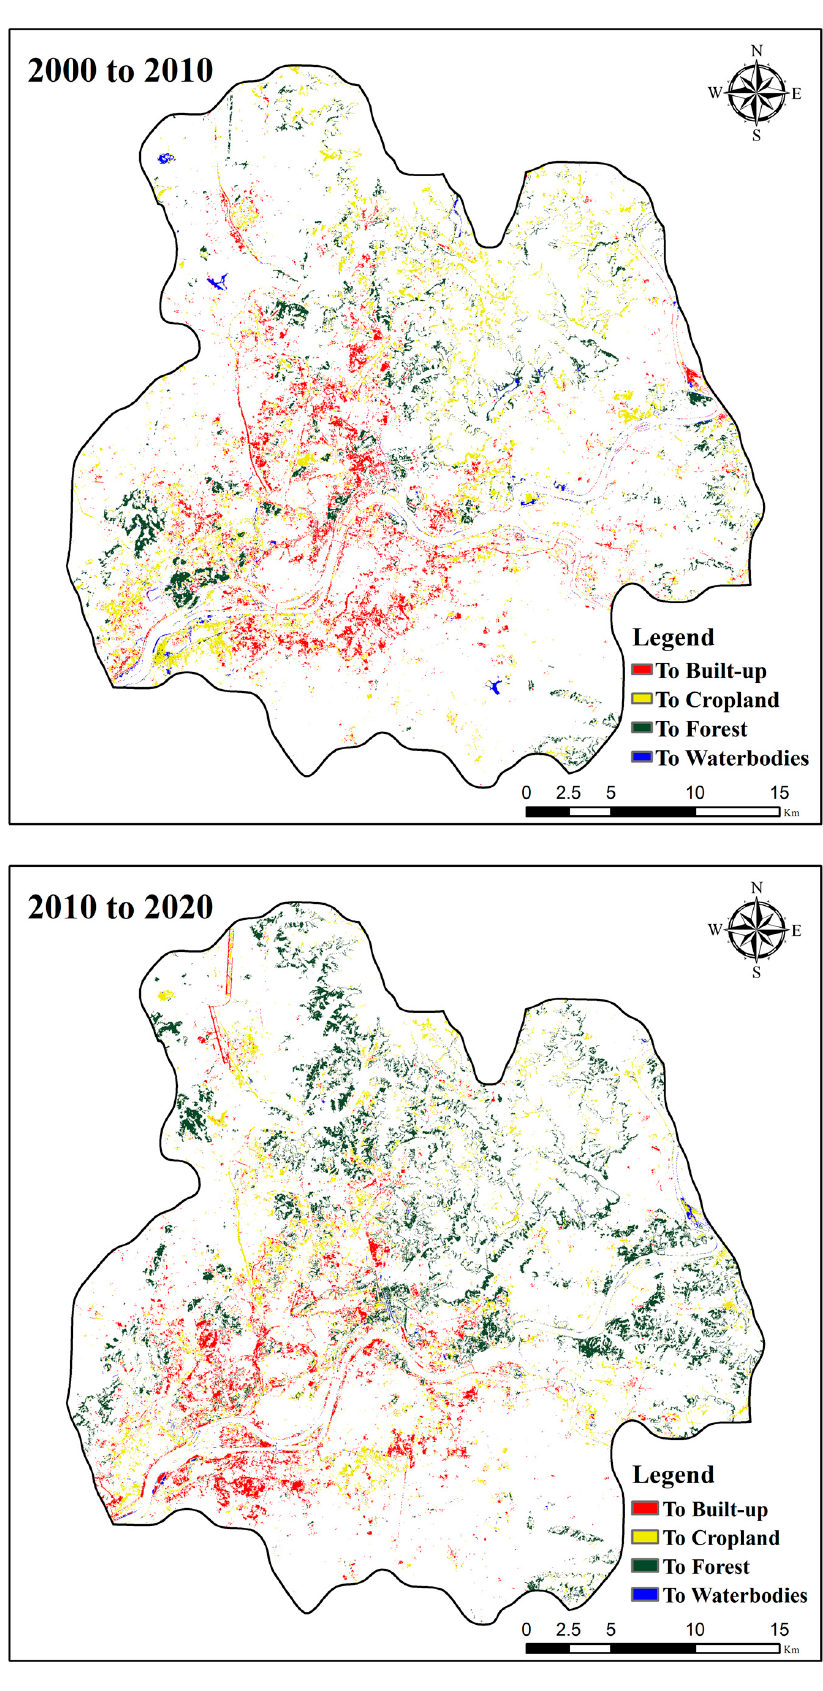
Figure 5. Land cover change maps for 2000–2010 and 2010–2020.